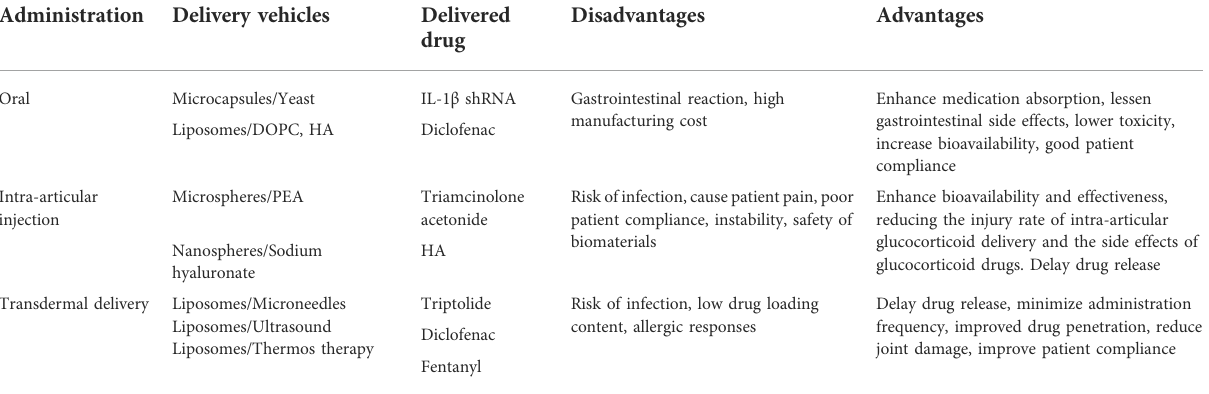
TABLE 4 Advantages and disadvantages between different delivery